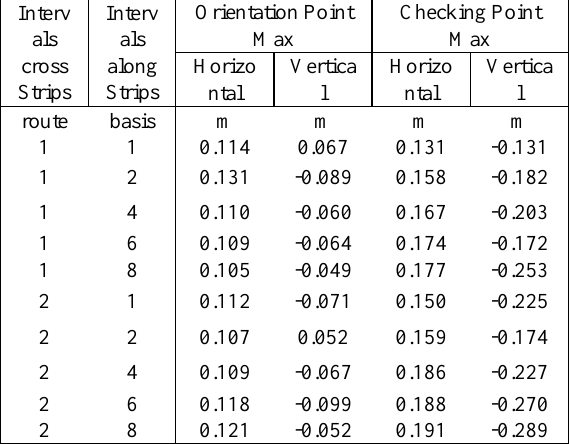
Table 5. Accuracy of area 2 by PixelGrid